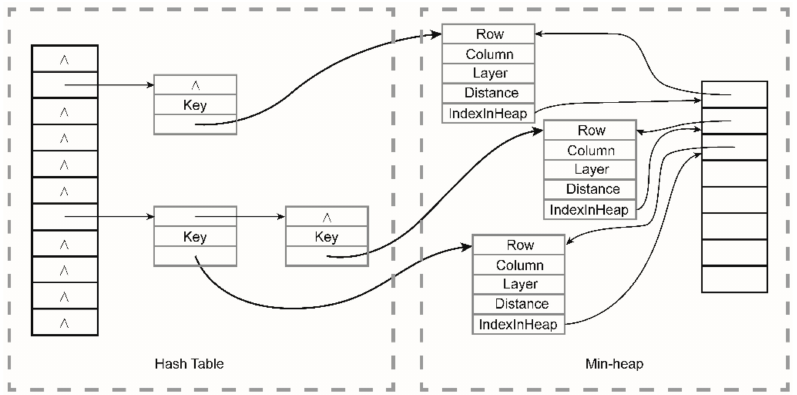
Figure 6. Data structure (a min-heap combined with a hash table) used in the implementation of the 3D cost distance